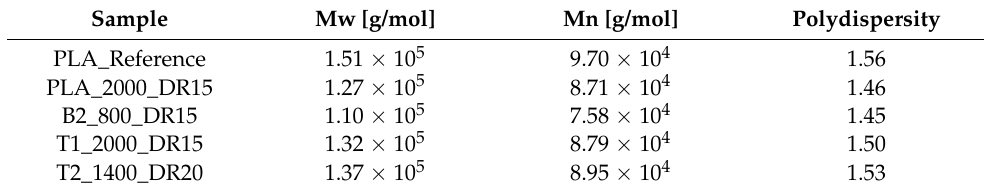
Figure 6. Molecular weight distribution for the processed fibers compared to pure PLA, as determined by gel permeation chromatography. The values for Mw and Mn are listed in Table 3. Table 3. Mw, Mn and polydispersity values for the samples tested in Figure 6.